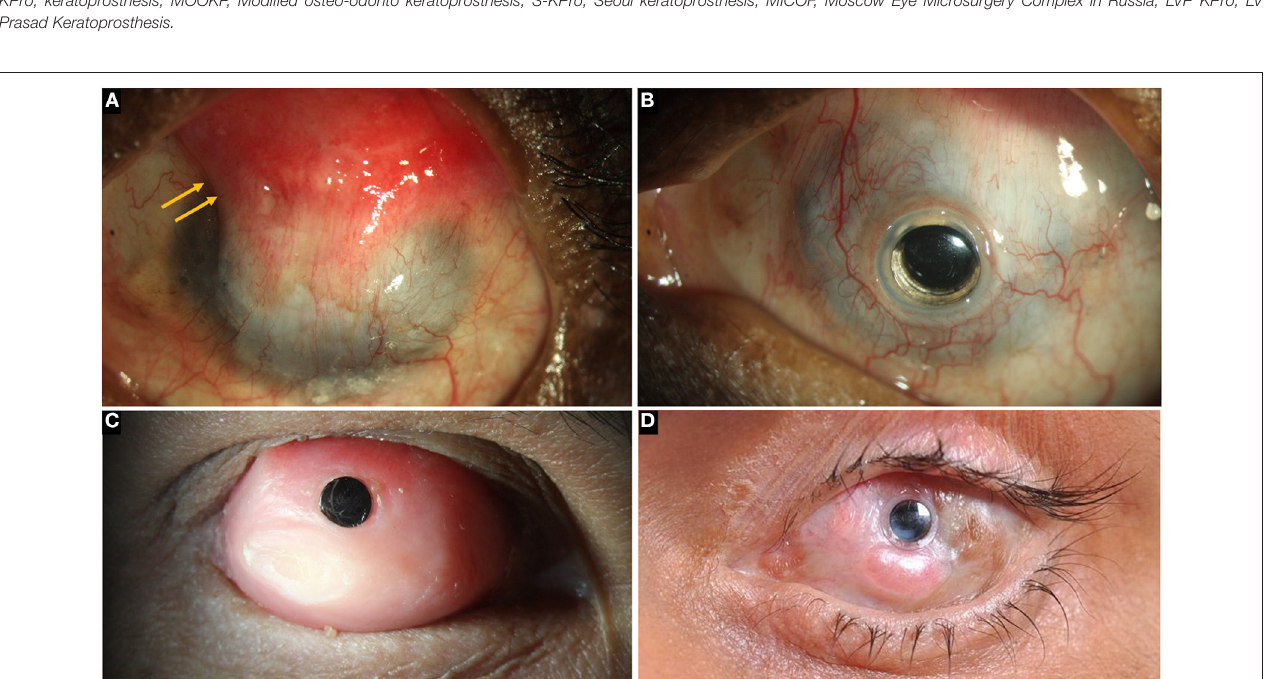
Frontiers in Medicine |